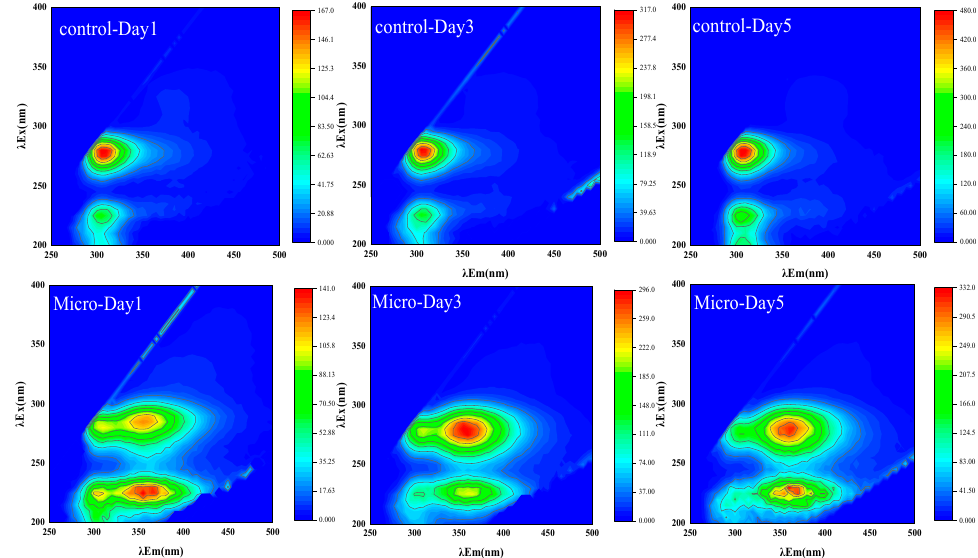
Figure 6. 3D-EEM at different time under microaerobic condition.